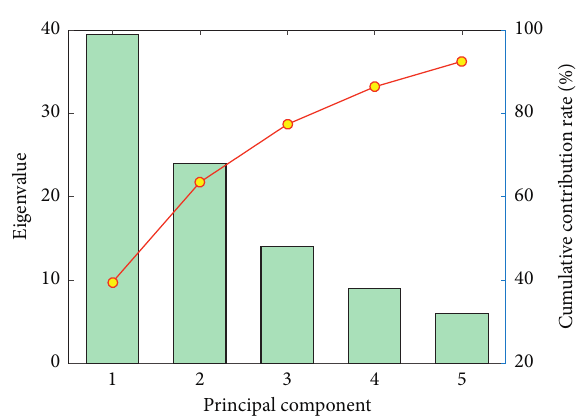
Figure 13: Histogram of the principal component contribution rate. Table 5: The new feature vectors after dimension